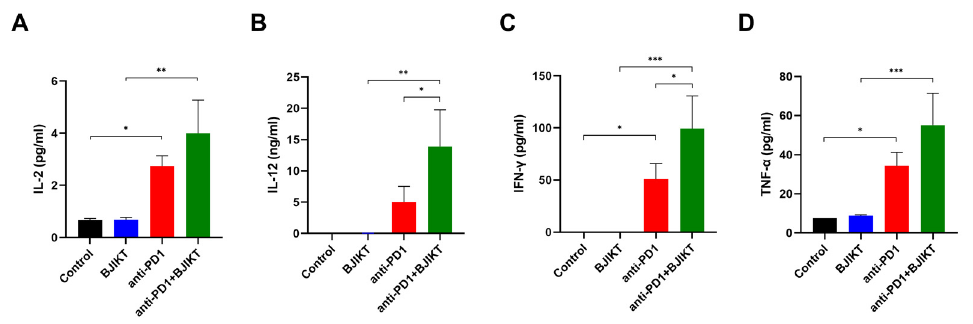
Figure 4. Change in inflammatory cytokine levels in plasma samples collected from mice. The levels of IL-2 ( A ), IL-12 ( B ), IFN- γ ( C ), and TNF- α ( D ) were determined by the Bio-Plex Pro ™ Mouse Cytokine Assay. * p < 0.05, ** p < 0.01, and *** p < 0.001, compared between each group.